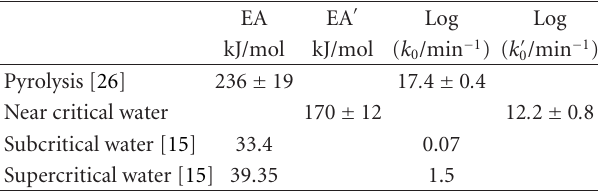
Figure 8: Arrhenius plot of guaiacol degradation in near critical water compared with experimental values from experiments in sub- and supercritical water and via